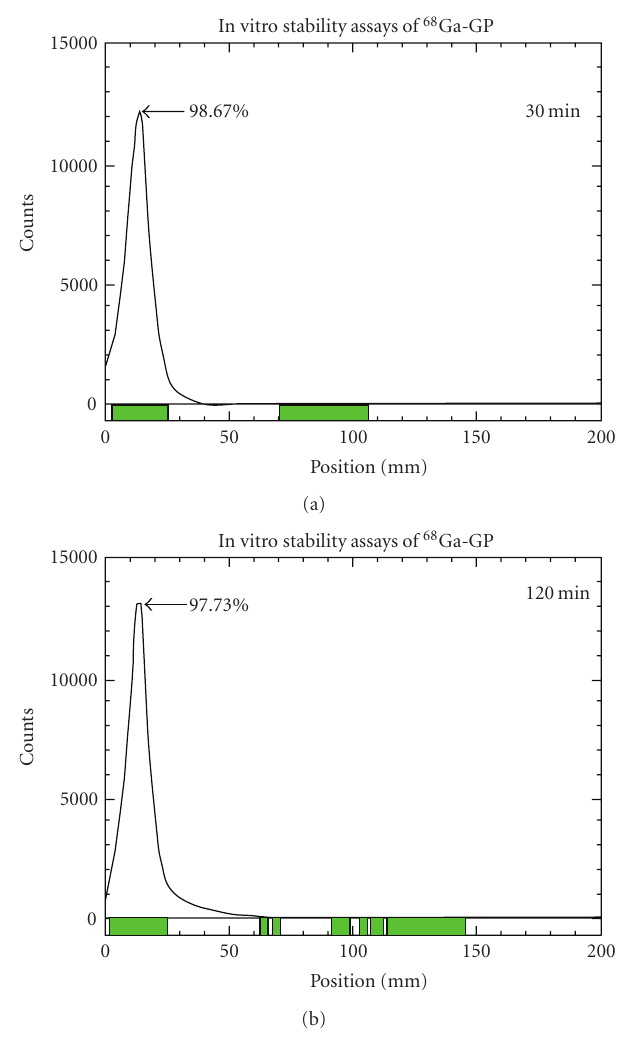
Figure 4: 68 Ga-GP was prepared in the concentration of 5mg/1mCi/1mL. 0.1mL of 68 Ga-GP was incubated with 0.1mL phosphate bu ff ered saline (pH = 7 . 4) at 30–120 min. There was no breakdown of 68 Ga-GP up to 120min.